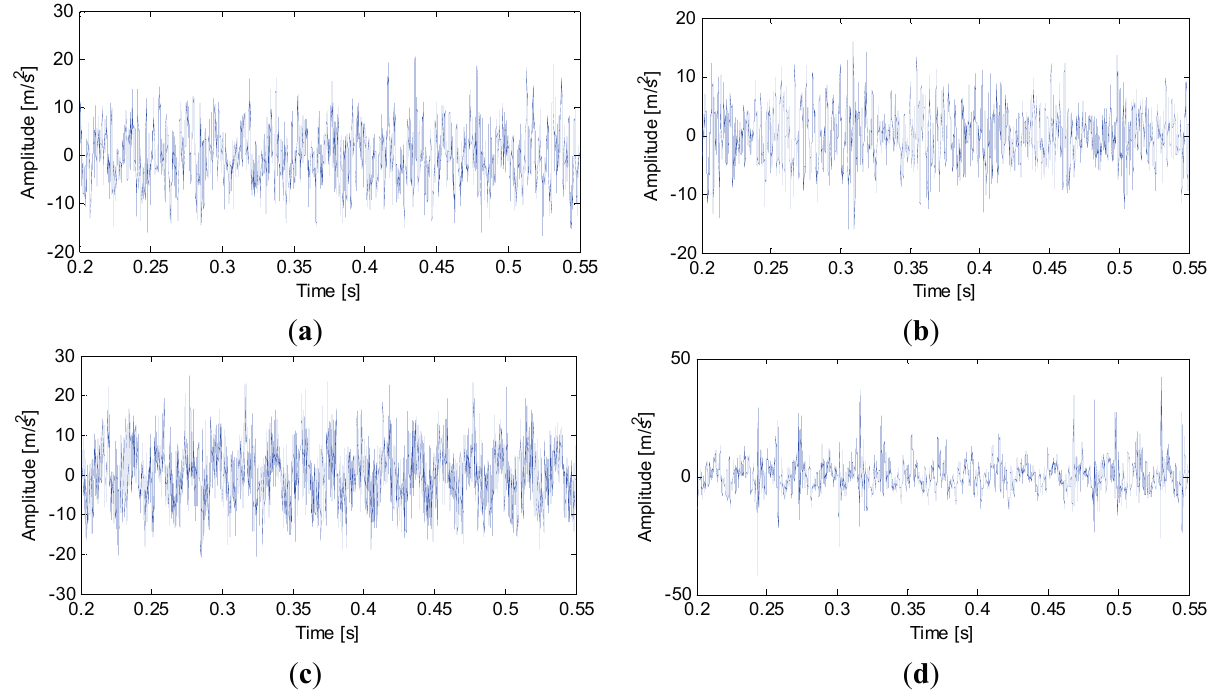
Figure 4. Axle-box vibration signals with undamaged and damaged axle bearings: ( a ) undamaged bearing; ( b ) outer ring fault bearing; ( c ) cage fault bearing; ( d ) pin roller fault